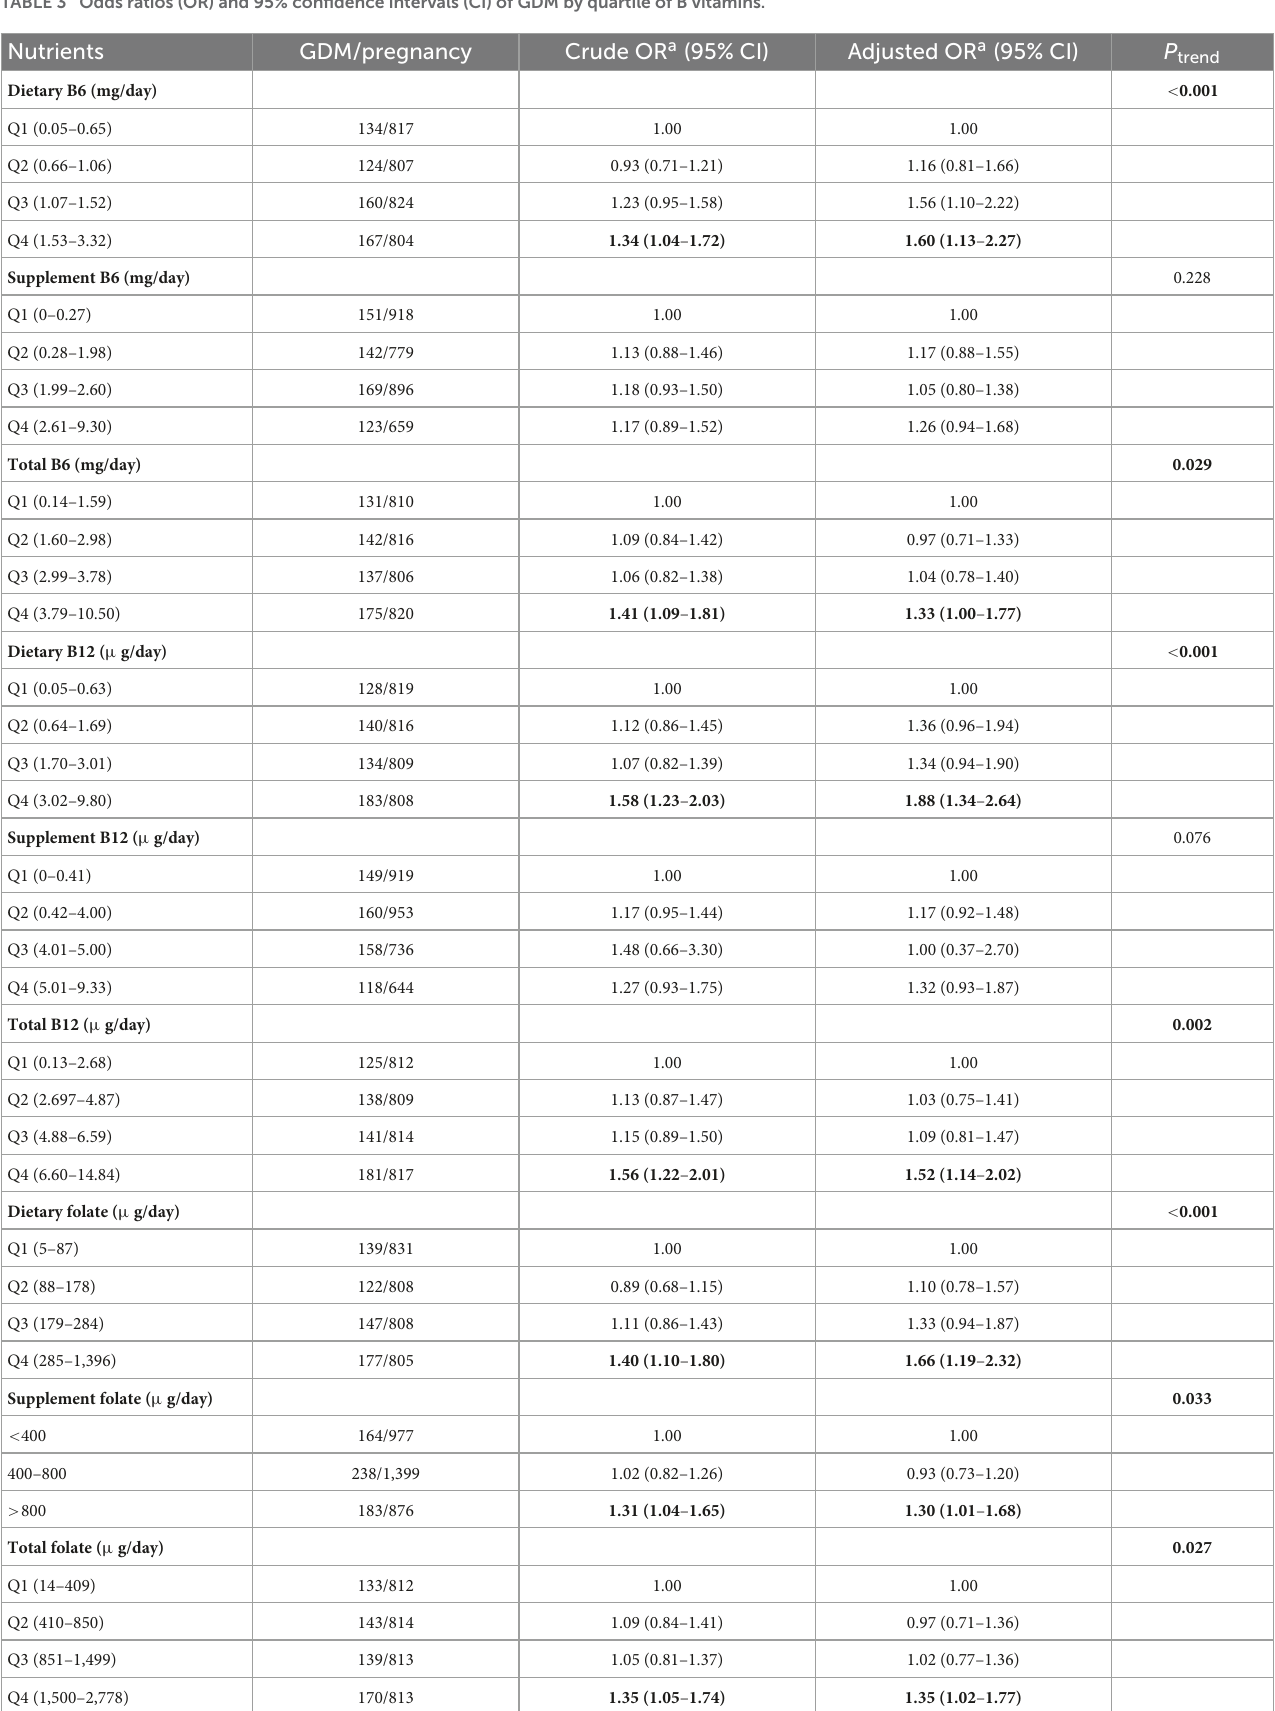
TABLE 3 Odds ratios (OR) and 95% confidence intervals (CI) of GDM by quartile of B vitamins.